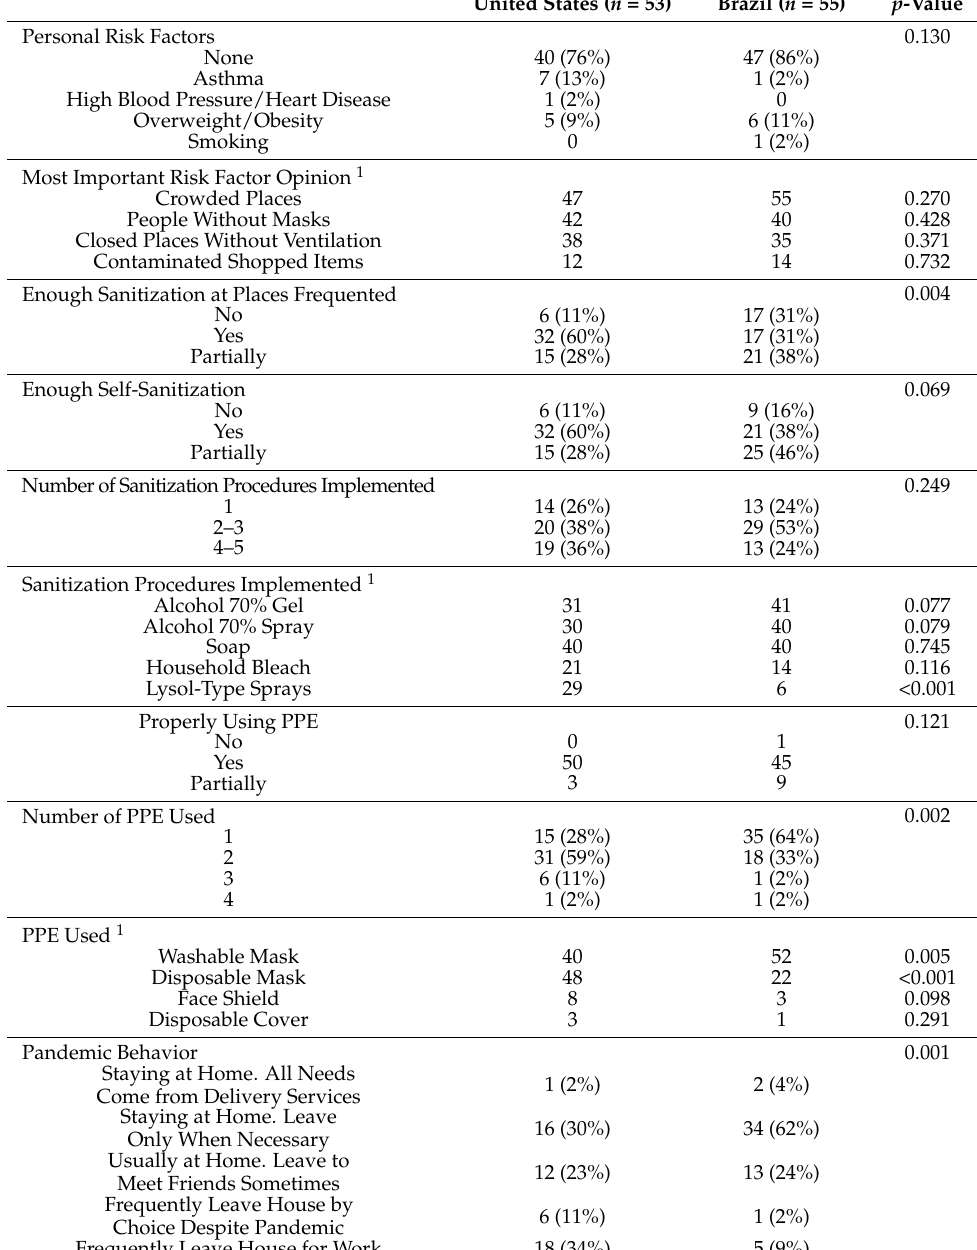
Table 3. Student perceptions and experiences around risk and protective behaviors during the COVID-19